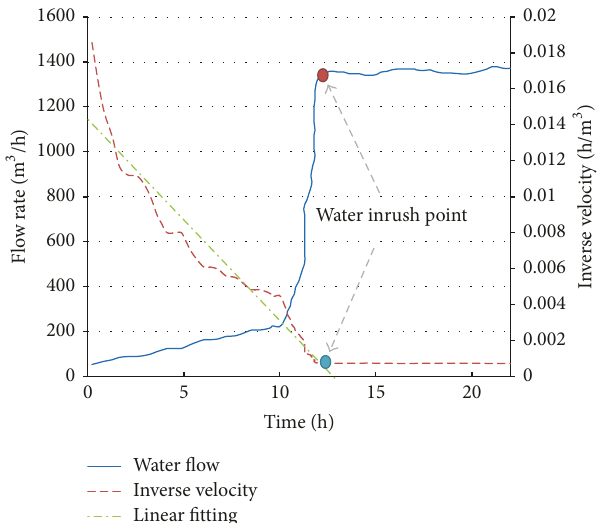
Figure 2. The mining operation is current extracting number 10 coal seam at approximately 300 m depth. To date, 97 KCPs have been found during the mining operations at this